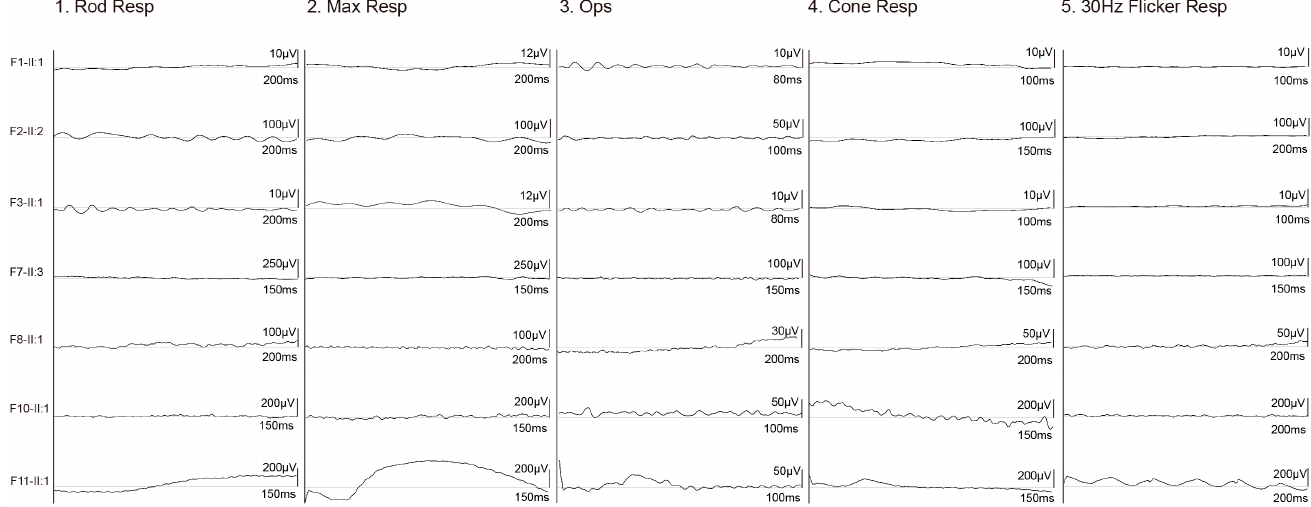
Figure 4. ERG of the seven patients with biallelic FDXR variants. ERG for both rods and cones were nonrecordable for F1-II:1, F2-II:2, F3-II:1, F7-II:3, F8-II:1, and F10-II:1, while severely reduced for patient F11-II:1. ERG,